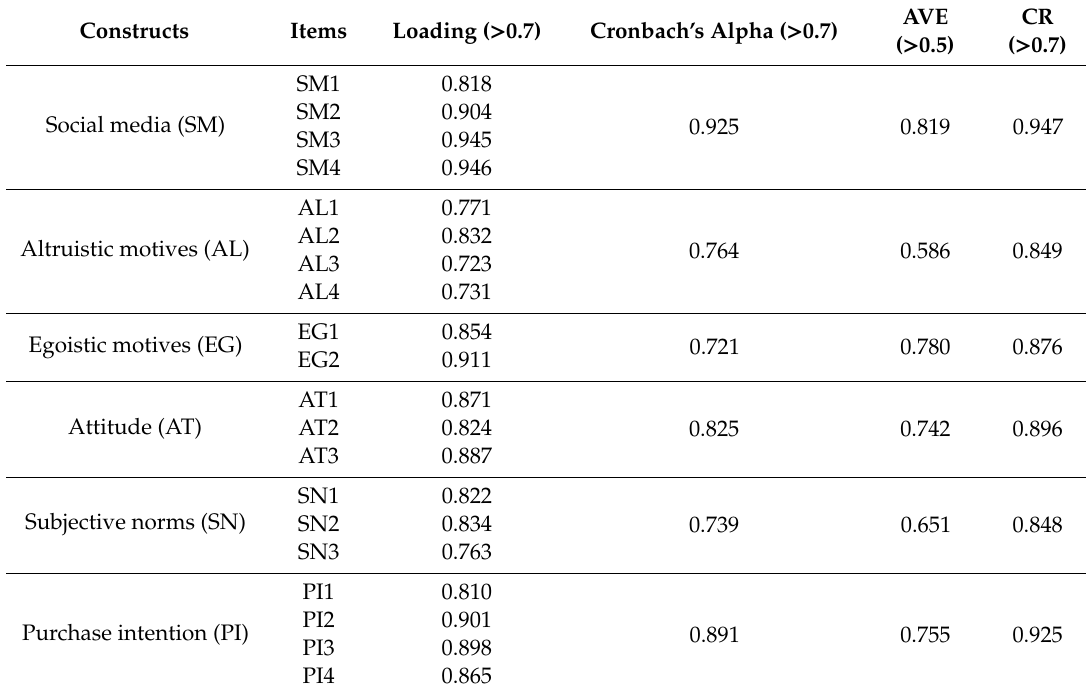
Table 3. Scale reliability.